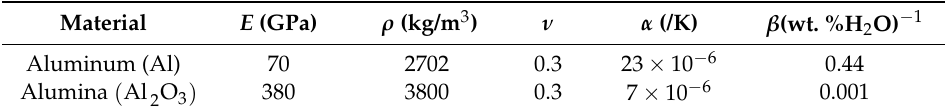
O 3 ) functionally graded (FG) doubly-curved 2